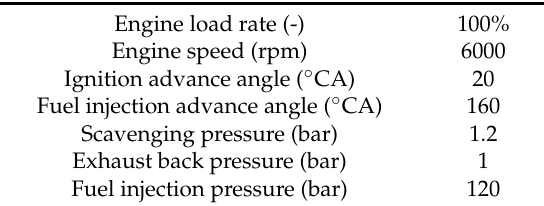
Table 2. OP2S-GDI engine operating